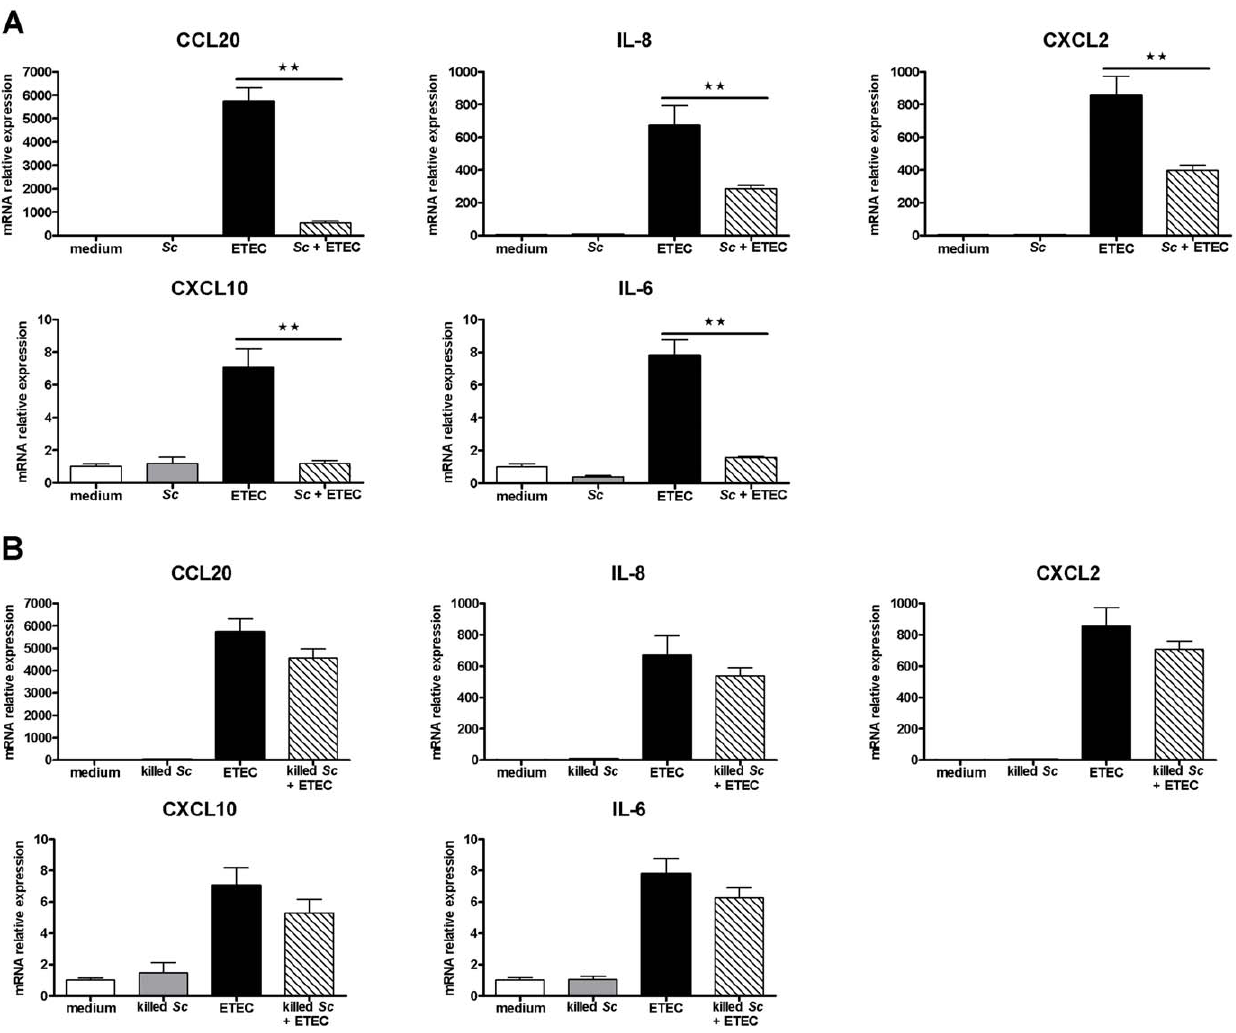
Figure 2. Viable Saccharomycescerevisiae down-regulates cytokine and chemokine mRNA relative expressions induced by ETEC. Differentiated IPEC-1 cells were cultured overnight with (A) viable Sc or (B) killed Sc (3 6 10 6 yeasts/well) and then ETEC (3 6 10 7 CFU/well) was added to the co-culture for 3 h. Gene expression was analysed by RT-qPCR. Data are presented as means 6 SEM ( n =6), asterisks denote: ** ( P , 0.01 ). (A) Data are representative of three independent